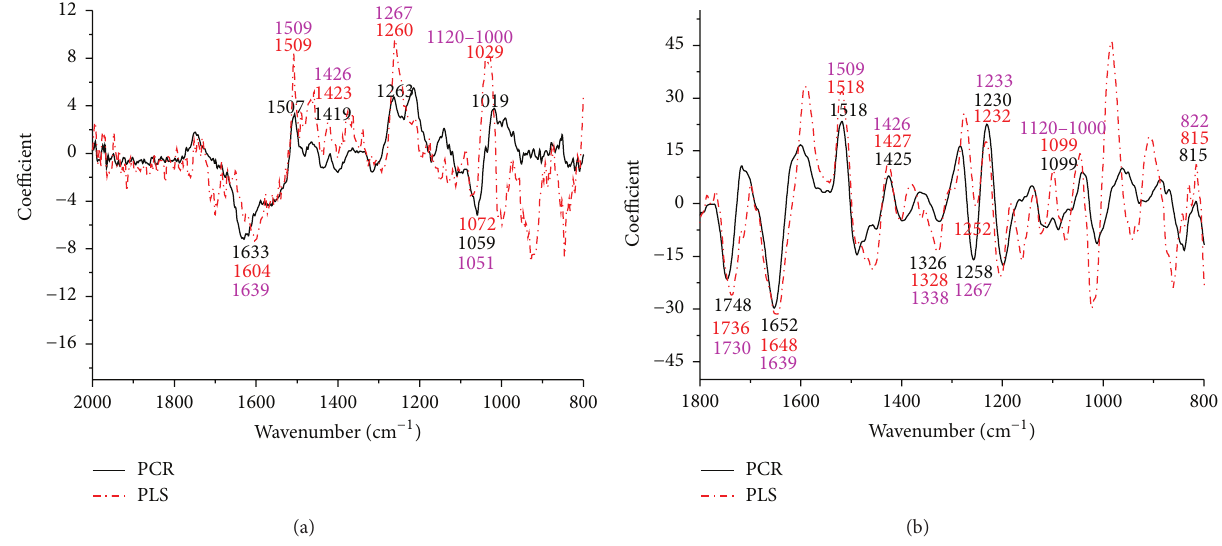
Figure 5: Coefficients by wavenumber for PCR and PLS for hemicellulose prediction (a) when raw spectra were processed and (b) when a first-derivative pretreatment was processed. PC numbers 3, 3, 1, and 1 were chosen for PCR-raw, PLS-raw, PCR-derivative, and PLS derivative, respectively ( 𝛼 = 0.05